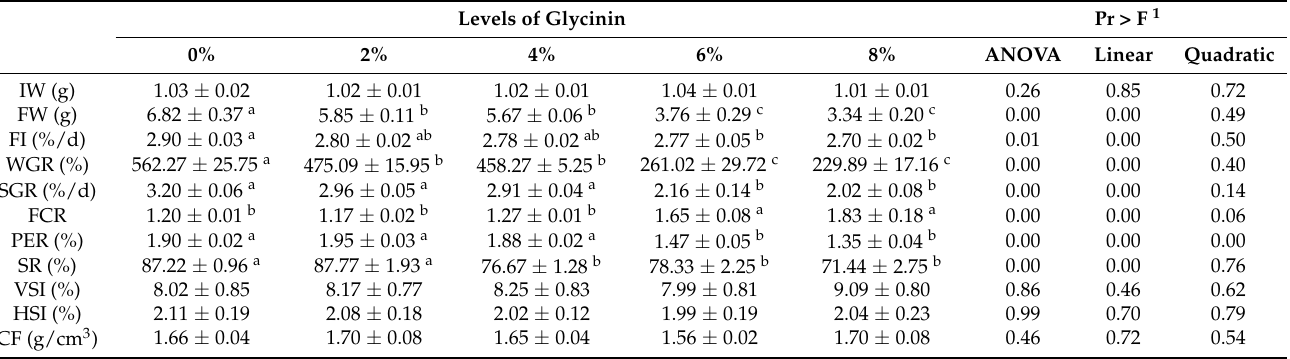
Table 1. Growth performance and feed utilization of trial ingredients for hybrid yellow catfish. Levels of Glycinin Pr > F 1